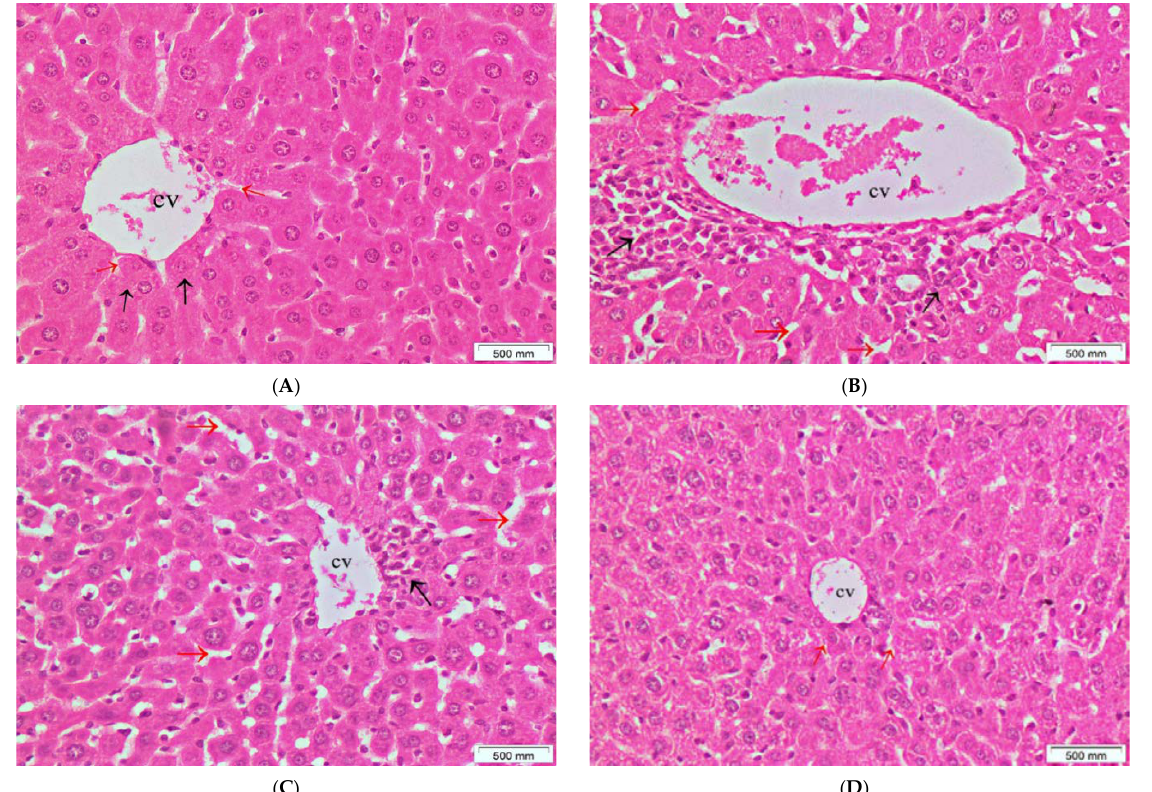
Figure 7. A photomicrography of liver tissue (H&E, x200). ( A ) normal control group; shows normal hepatic architecture, with clear central vein (CV) and hepatocytes radially arranged in plate (black arrows), and normal sinusoidal spaces between them (red arrows). ( B ) cisplatin group; shows infiltration of inflammatory cells (black arrows), with congested central vein (CV) and dilated sinusoidal spaces (red arrows). ( C ) S. cornutus (250 mg/kg) group; shows partial improvement, less infiltration of inflammatory cells (black arrows), but still dilated sinusoidal spaces (red arrows). ( D ) S. cornutus (500 mg/kg) group; shows the best improvement, nearly normal hepatic architecture, and restoration of normal sinusoidal spaces (red arrows).